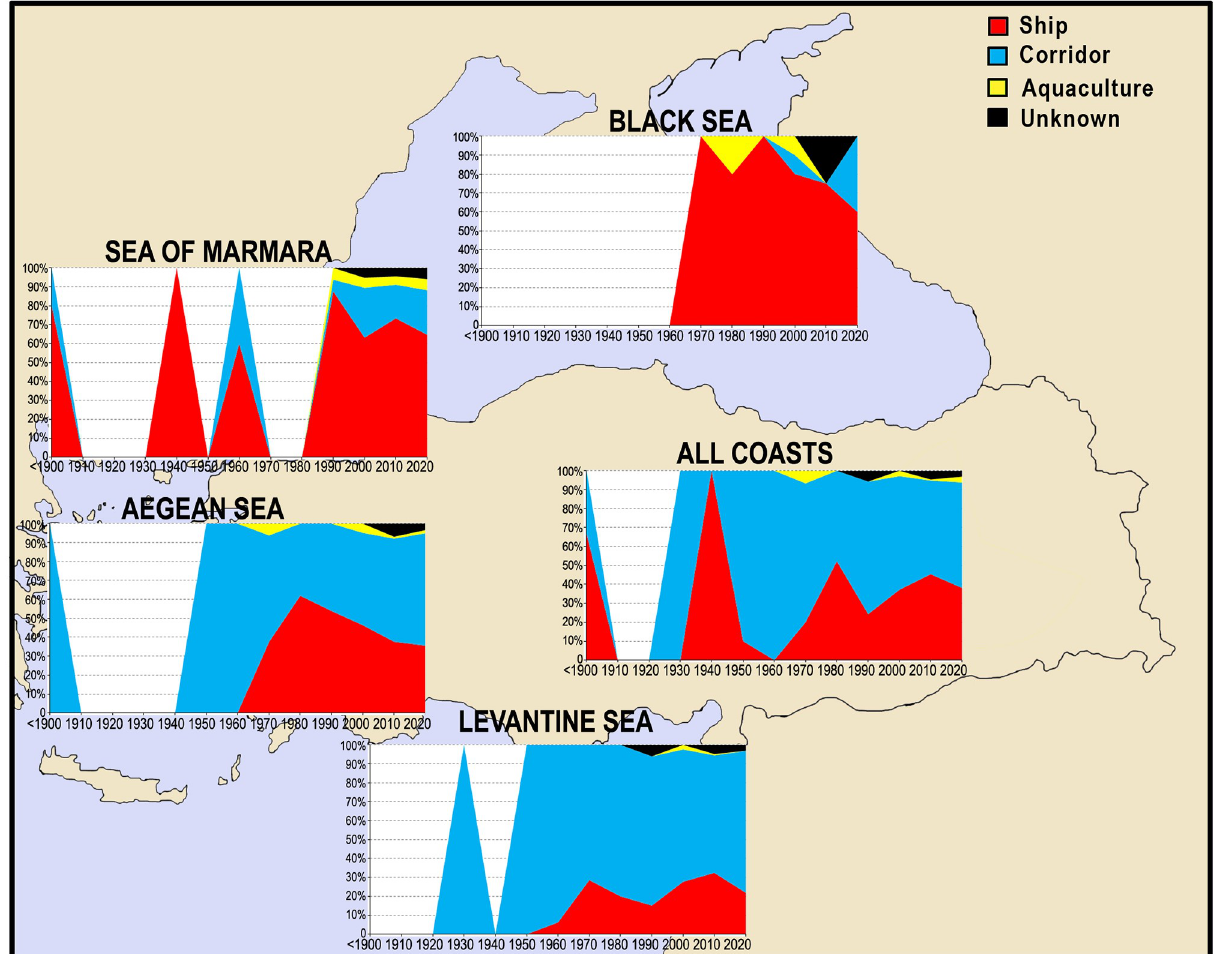
Fig 10. The trends in the importance of primary pathways in species introductions in seas per decade.